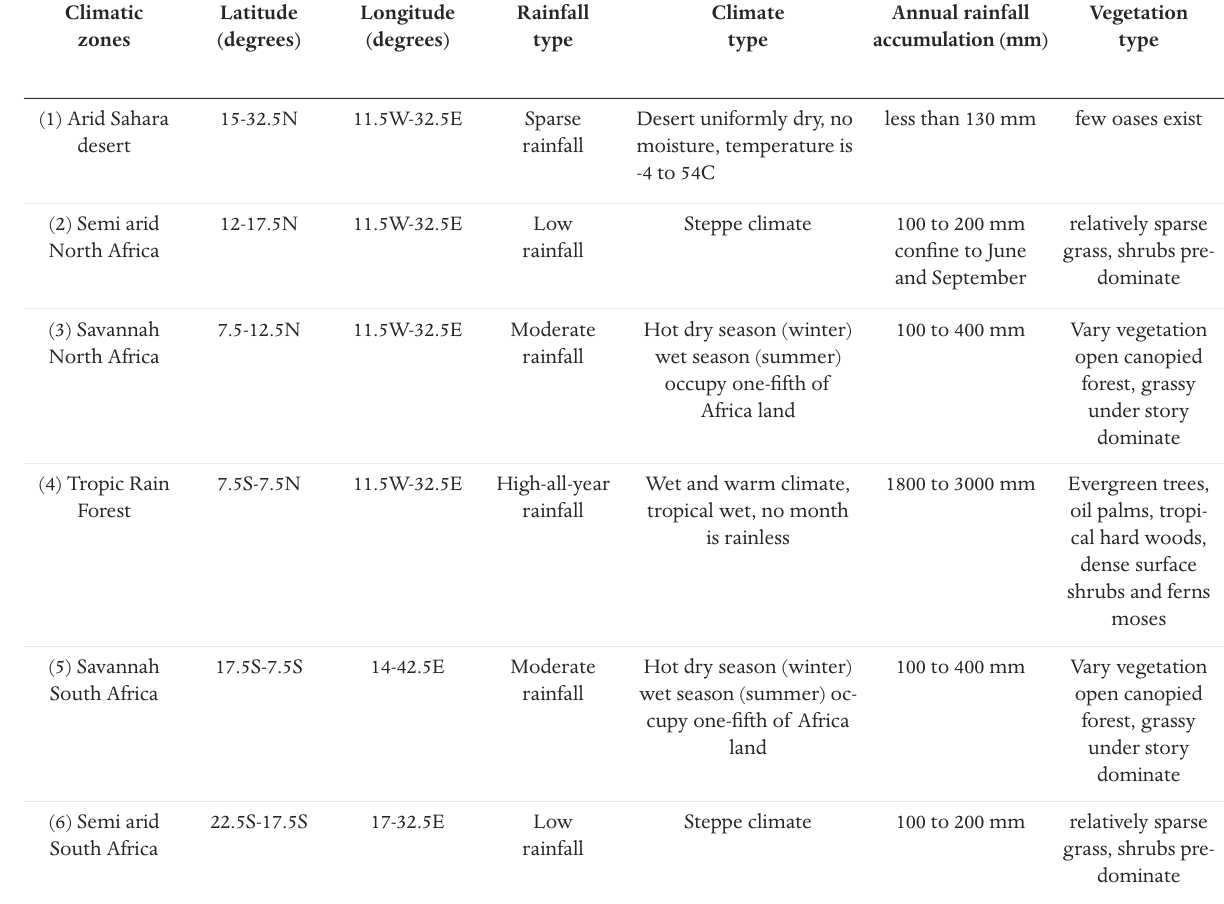
Table 1. Climate summary and geographical coordinates of the of the six climatic